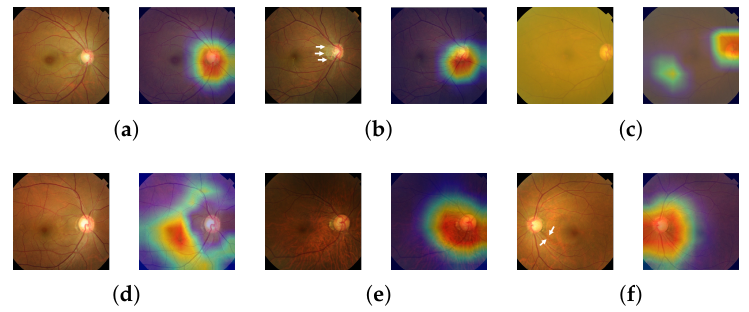
Figure 8. False localization examples. The first three figures, from ( a – c ), represent false positive examples, and the next three figures, from ( d – f ), represent false negative examples.